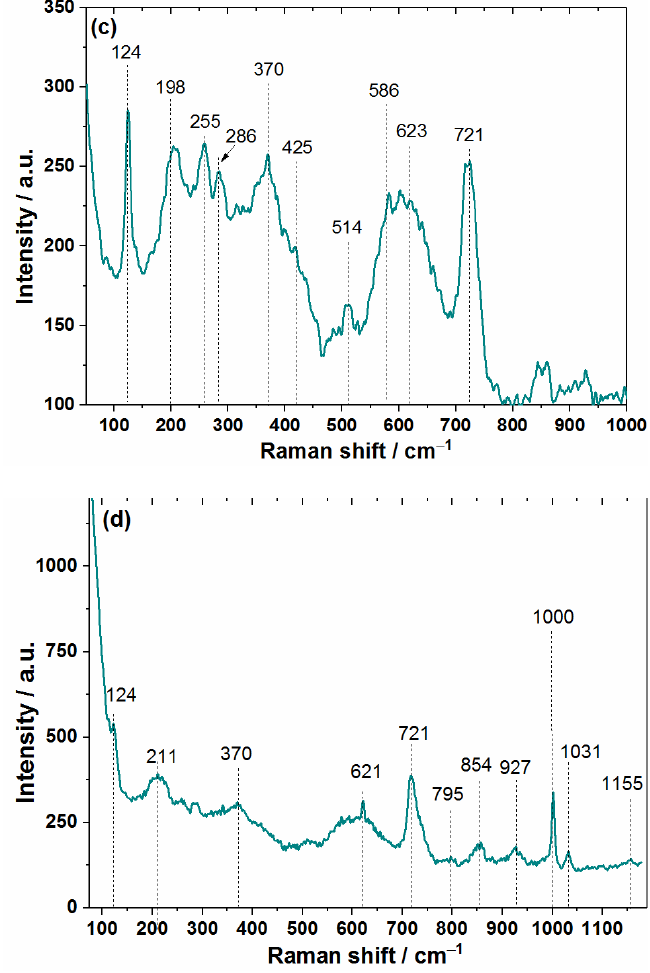
Figure 4. Raman spectra of pristine Ti 3 C 2 T x MXene films excited by 532 and 785 nm lasers ( a ) and polymer-coated Ti 3 C 2 T x MXene films excited by 785 nm laser (( b )—PSt-MXene; ( c )—PIB-MXene; ( d )—SIBS-MXene).